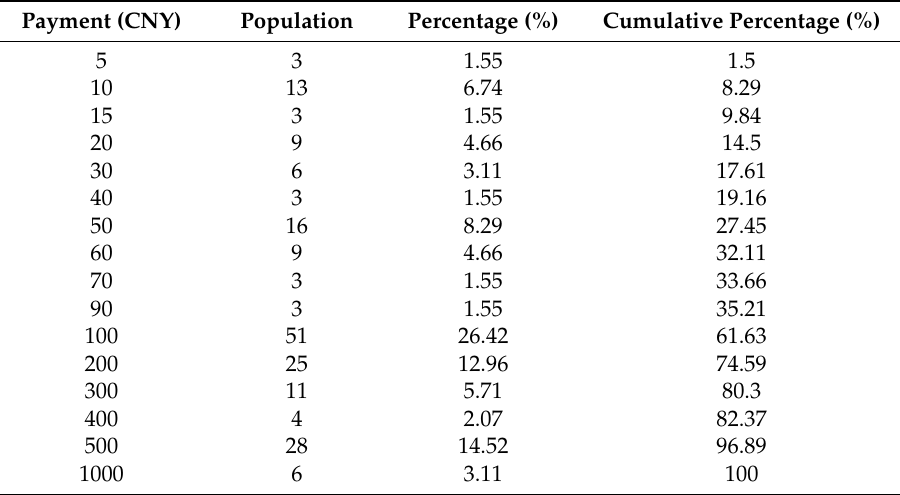
Table 8. Willingness to pay (WTP) in survey.